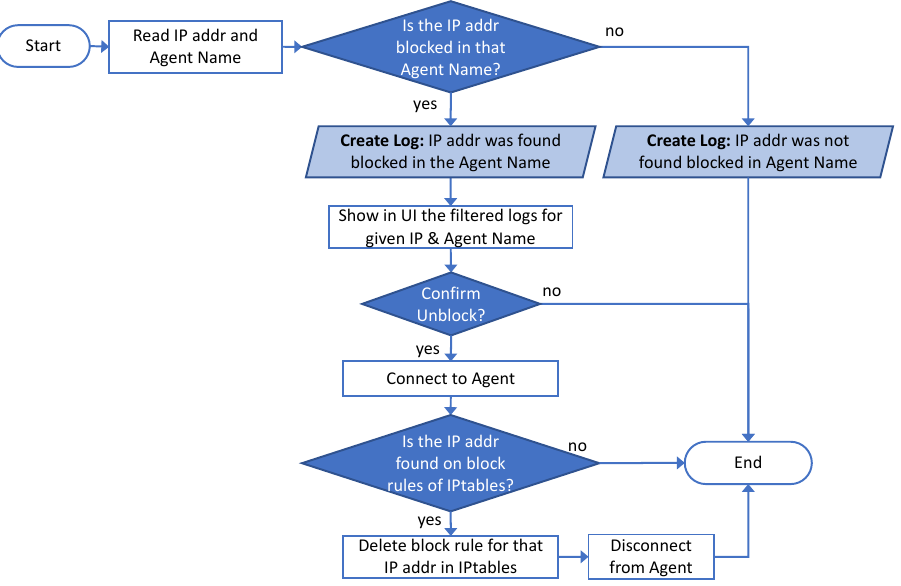
Figure 4. Procedures to check and unblock an IP addresses in an